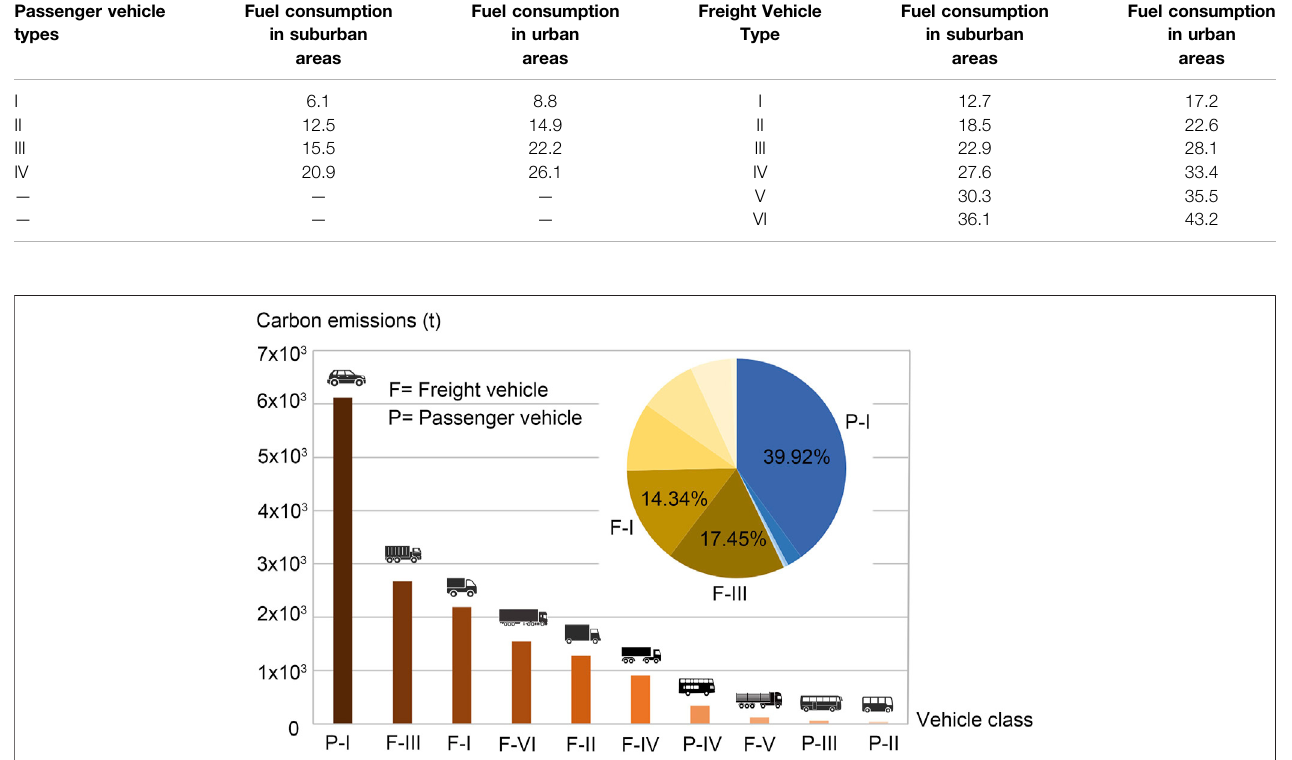
FIGURE 4 | Vehicle carbon emissions on highways in